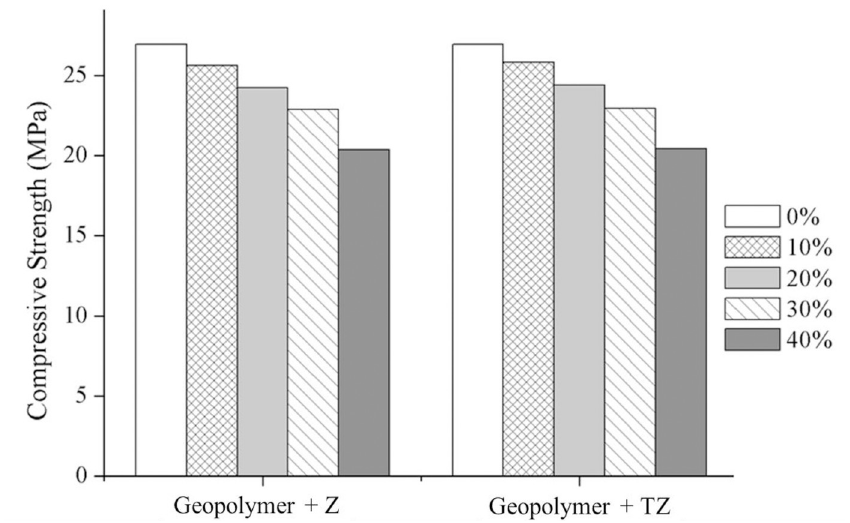
Fig 9. Compressive strength of MK-based geopolymer containing different amounts of zeolite and TiO 2 /zeolite.